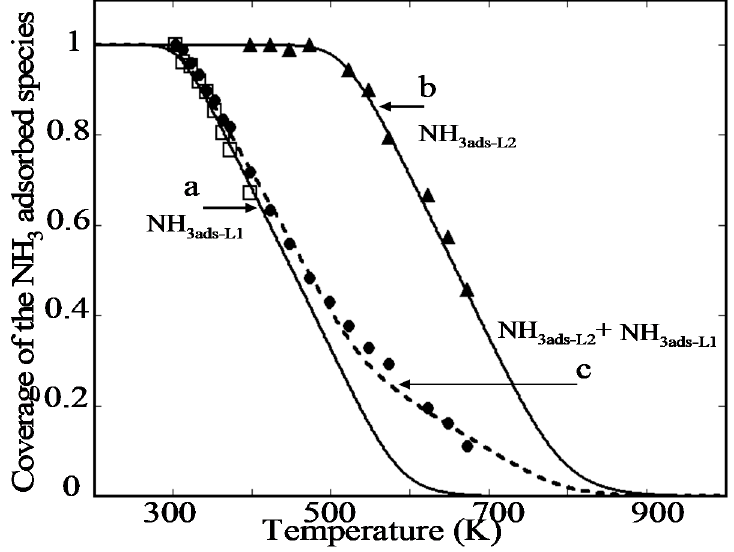
Figure 4. Heats of adsorption of the adsorbed NH 3 species on TiO 2 -P25 using the AEIR method. ▲ and □ coverages of the NH 3ads-L2 and NH 3ads-L1 adsorbed species respectively using their δ s IR bands; full lines: (a) and (b) theoretical coverages of the NH 3ads-L1 and NH 3ads-L2 species respectively using Equations (4) and (5) with E L1 (1) = 56 kJ/mol, E L1 (0) = 102 kJ/mol, E L2 (1) = 102 kJ/mol and E L2 (0) = 160 kJ/mol; ● average coverage of the NH 3ads-L1 and NH 3ads-L2 species using their common δ as IR band at 1596 cm − 1 ; (c) theoretical evolution of the average coverage of the NH 3ads-L species using Equation (6) considering x 1 = 0.73 and x 2 = 0.27 for the NH 3ads-L1 and NH 3ads-L2 species respectively and with heats of adsorption of E L1 (1) = 56 kJ/mol, E L1 (0) = 105 kJ/mol, E L2 (1) = 105 kJ/mol and E L2 (0) = 160 kJ/mol (see the text for more details).